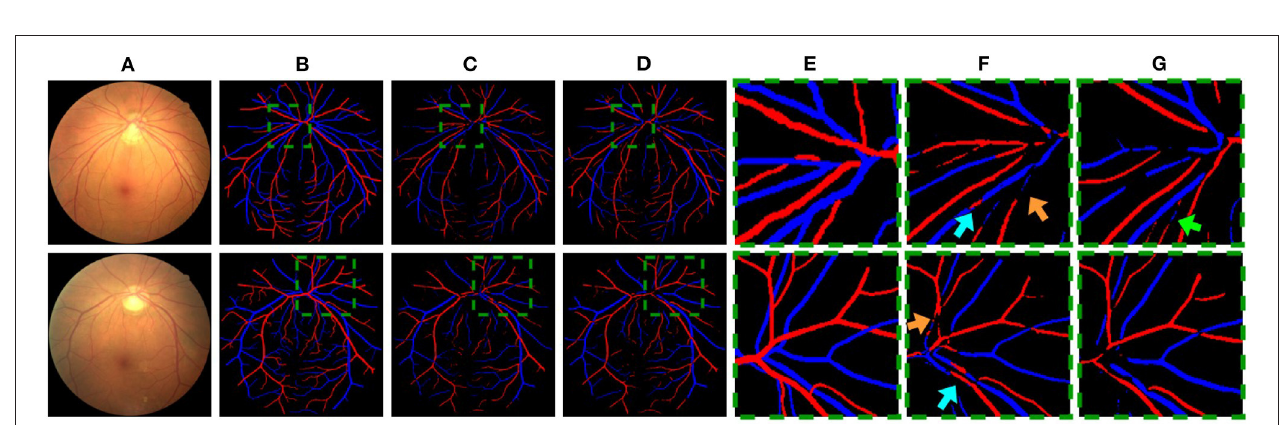
FIGURE 6 | (A,F) An image example and two image regions in it. (B,G) The corresponding ground truth. (C–E) The outputs of CNN, GCN, and VTG-Net. (H) CNN-only outputs by our CNN (cyan arrows highlight some vessels with multiple class assignments, and orange arrows mark limited vessel connectivity in the CNN-only outputs, which are rectified by our GCN as shown in I ).